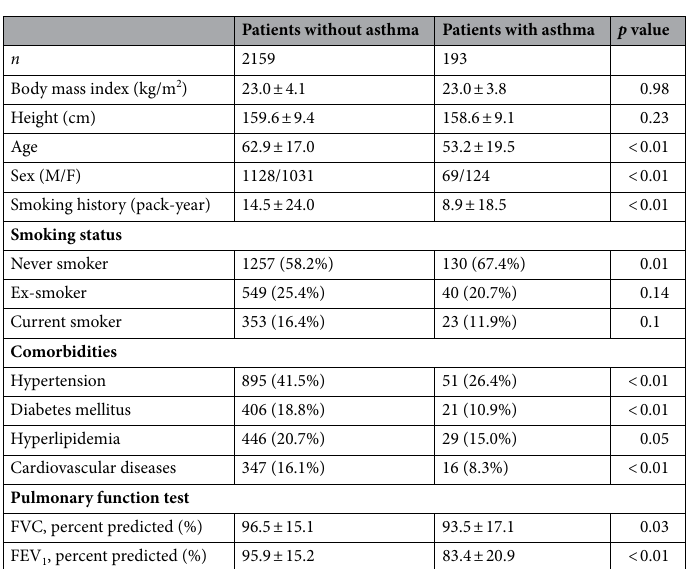
Table 1. Characteristics of patients with and without asthma. FVC, forced vital capacity; FEV 1 , forced expiratory volume in 1 s.